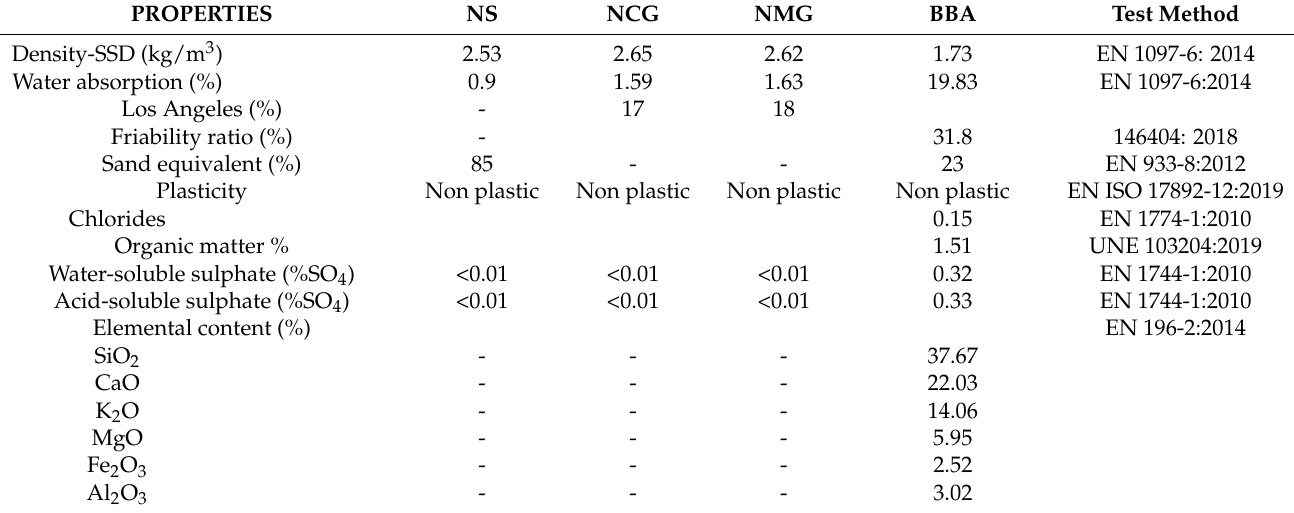
Table 2. Physical and chemical properties of natural aggregates and BBA.